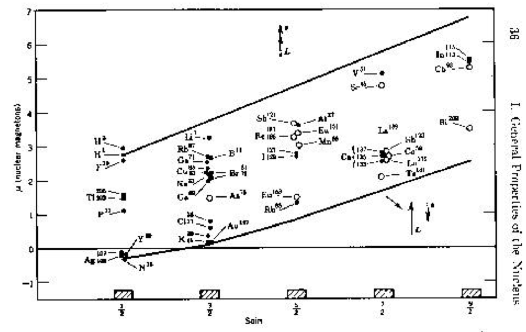
Figure 1: In this figure, we present the so-called Schmidt limits essentially representing the deviations of experimental data on nuclear magnetic moments from the predictions of quantum mechanics. In Santilli’s view [11], this occurrence is clear evidence on the need for a “completion” of quantum mechanics along Einstein’s legacy [1], beginning with a “completion” of applied mathematics into a form suitable to represent extended and deformable nucleons according to the founders of nuclear physics, such as E. Fermi [13] and V. F. Weisskopf who states in page 31 of his treatise in nuclear physics with J. M. Blatt [14]: “ it is possible that the intrinsic magnetism of a nucleon is different when it is in close proximity to another nucleon. ” For penetrating appraisals of the insufficiencies of 20th century science, one should also see K. R. Popper [15]. J. Dunning-Davies [16], J. Horgan [17] and others. In this paper, we outline and update the achievement by hadronic mathematics and mechanics of exact representations of nuclear experimental data along the indicated historical legacies, and point out important implications for much needed new, clean energies and fuels (Sections 2.6.5, 2.7.3,